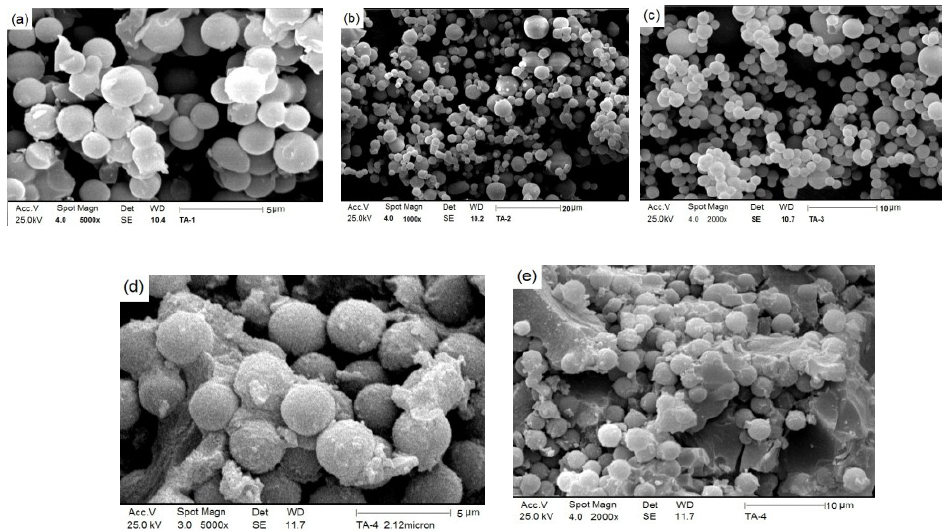
Figure 11. Synthesized particles produced in different reaction periods: a) 30 min, b) 60 min, c) 6 h, d) 24 h, e) 1